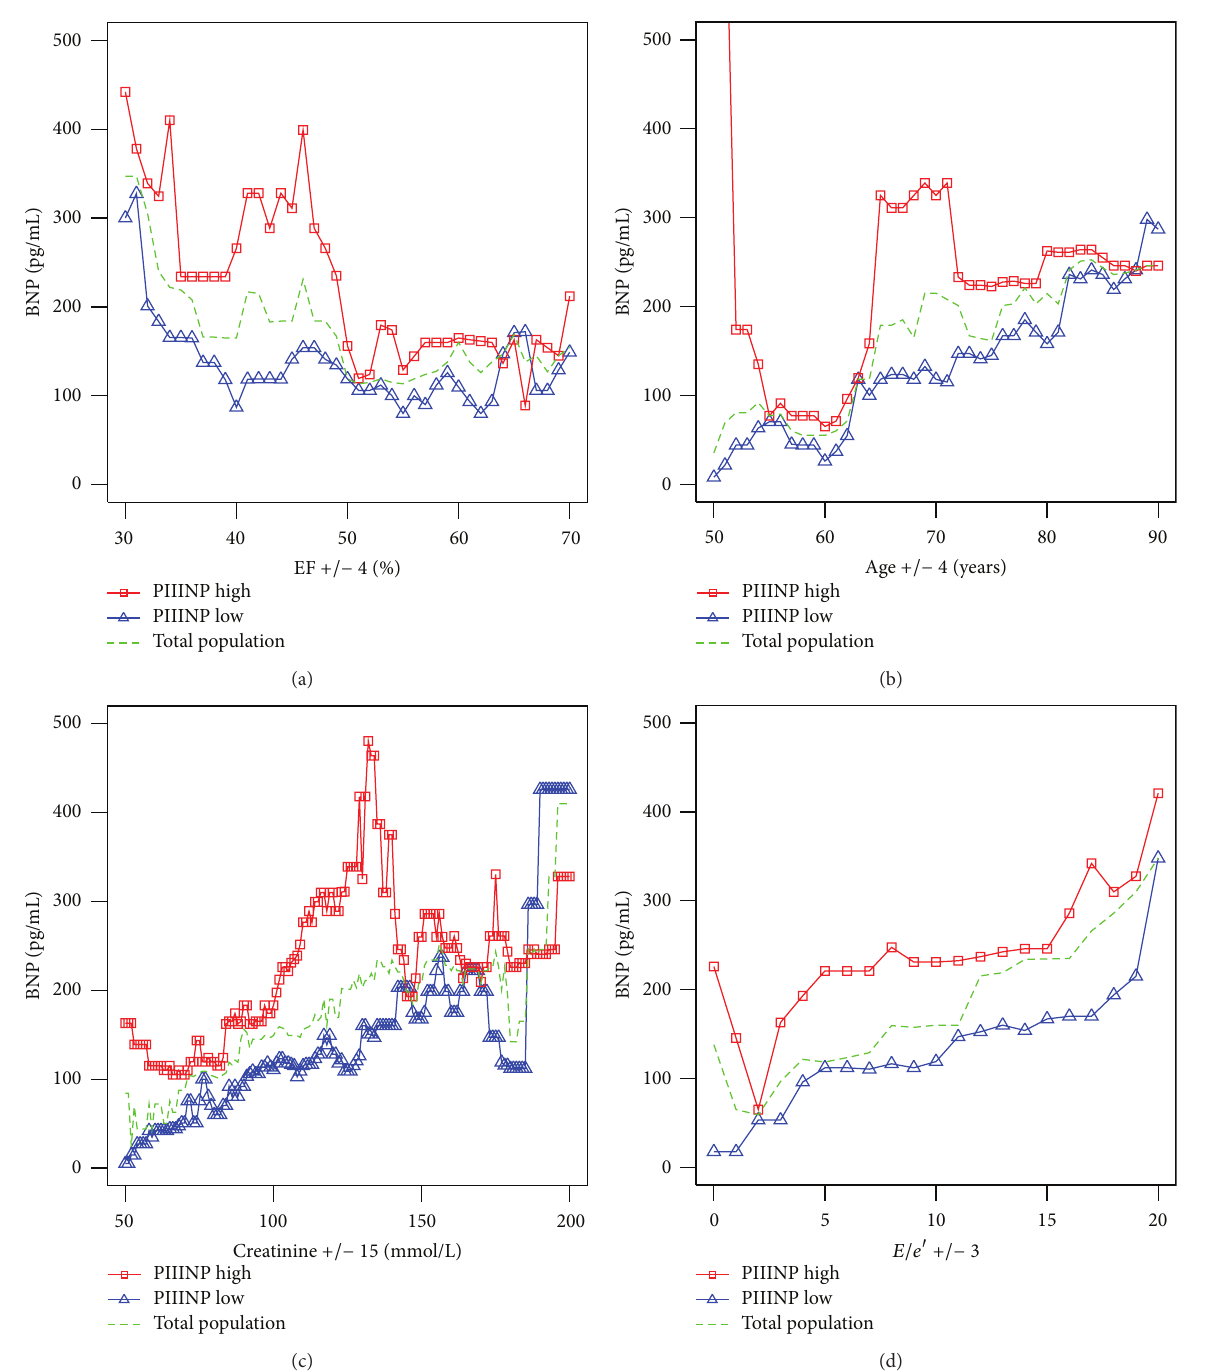
Figure 1: Projection of BNP onto its principal associates when population is dichotomized by median PIIINP of 4.72 ( 𝜇